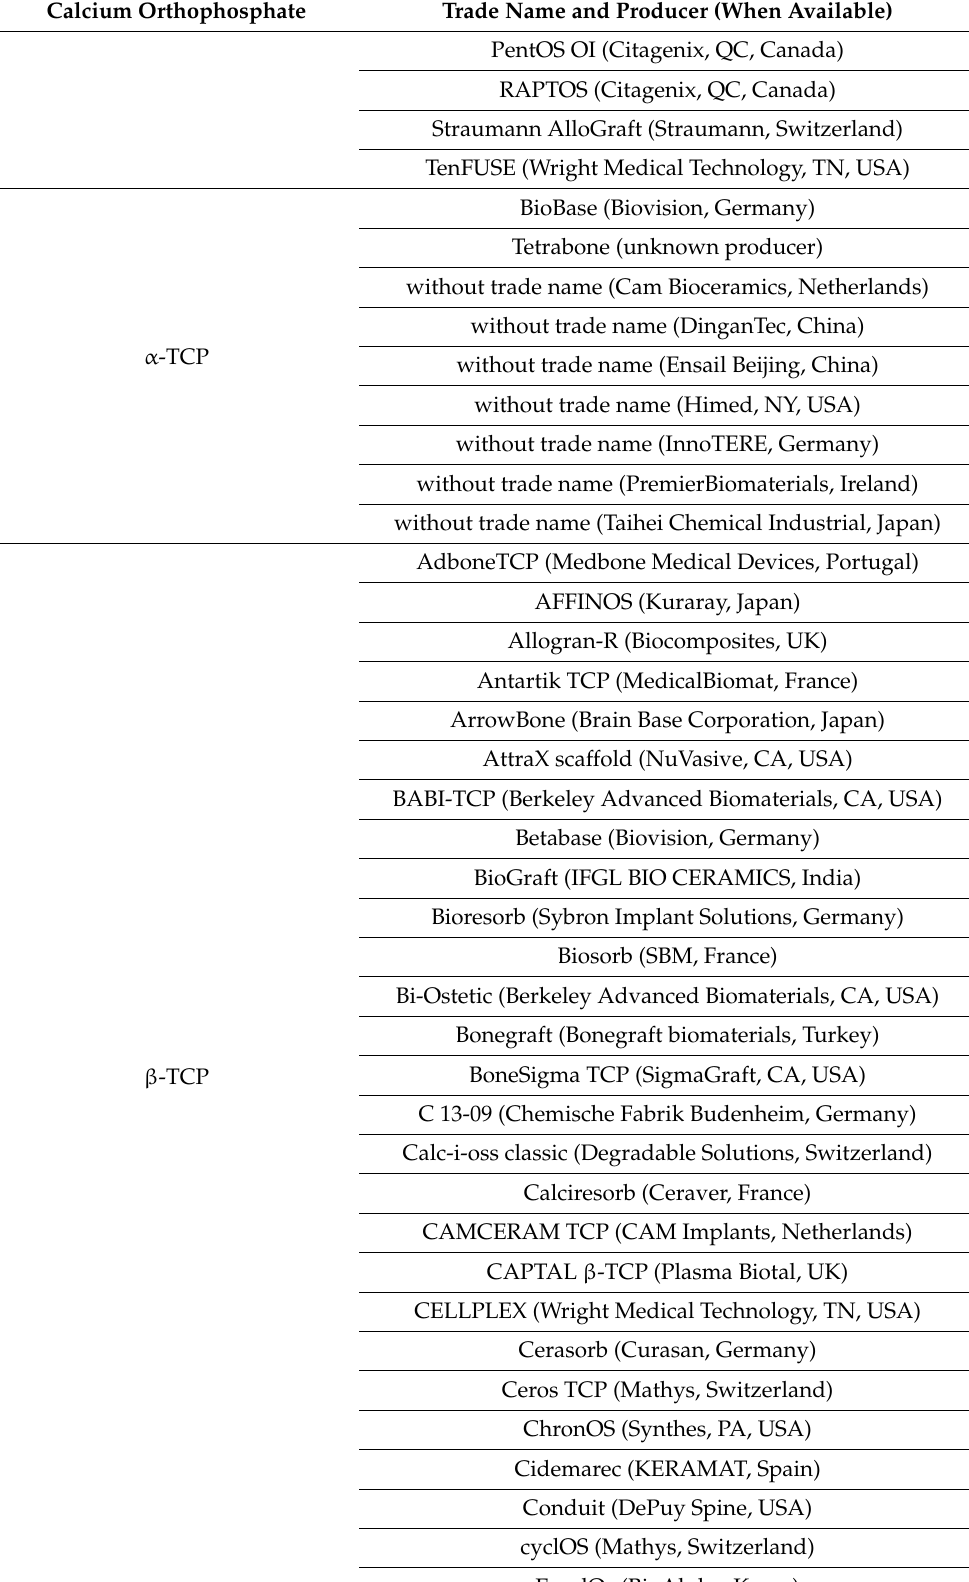
Table 3. Cont . Calcium Orthophosphate Trade Name and Producer (When